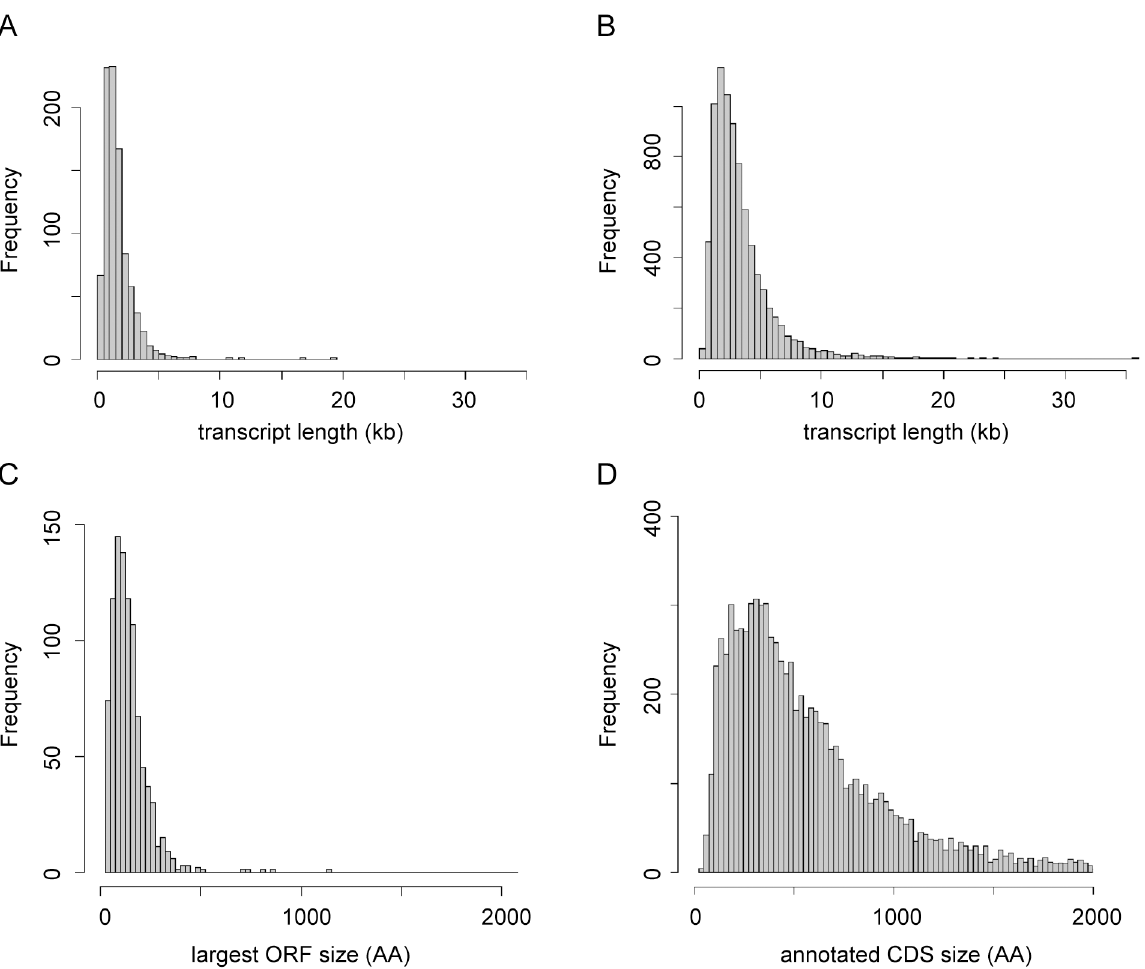
Fig 3. Characterisation of novel transcripts. (A) Size distribution of novel transcripts (n = 936). (B) Size distribution of transcripts derived from genes annotated in TriTrypDB V6 (n = 8,250). (C) Size distribution of largest ORFs found on the sense strand of novel transcripts (n = 936). (D) Size distribution of CDS annotated in TriTrypDB V6 (n = 8,250).